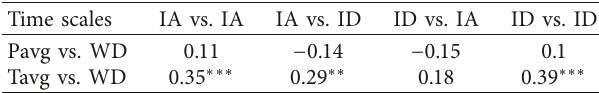
Figure 6: Interannual and interdecadal fluctuations as well as a nonlinear change trend of WD anomaly series during the period 1961–2009 over the upper reach of the YZRB. Table 5: Correlation between climate change and WD fluctuations during 1961–2009 in the upper reach of the YZRB.